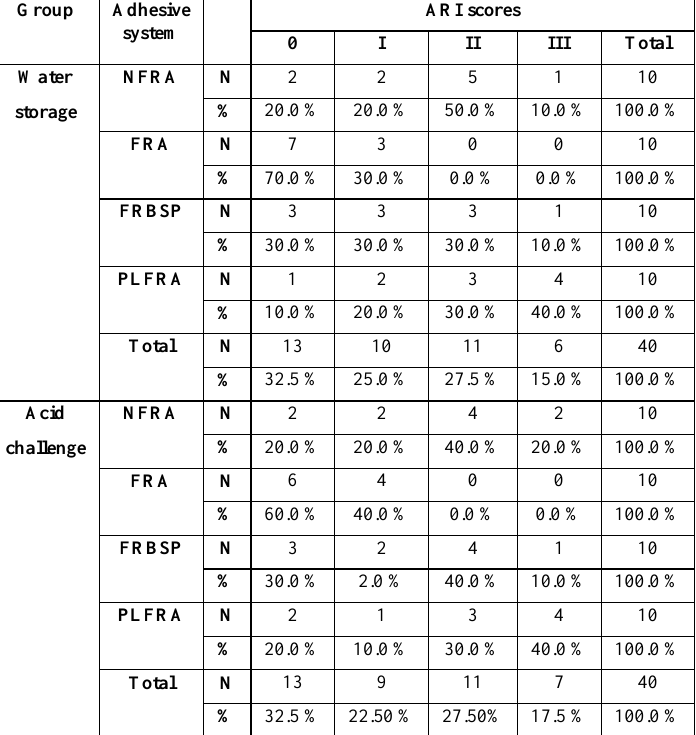
Table 3: Frequency distribution and percentages of adhesive remnant index among different adhesive systems in both ageing groups.